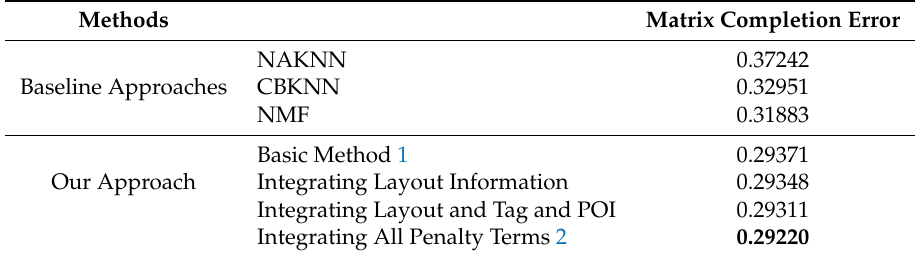
Table 2. The estimate error of our method and baseline methods. NMF, negative matrix